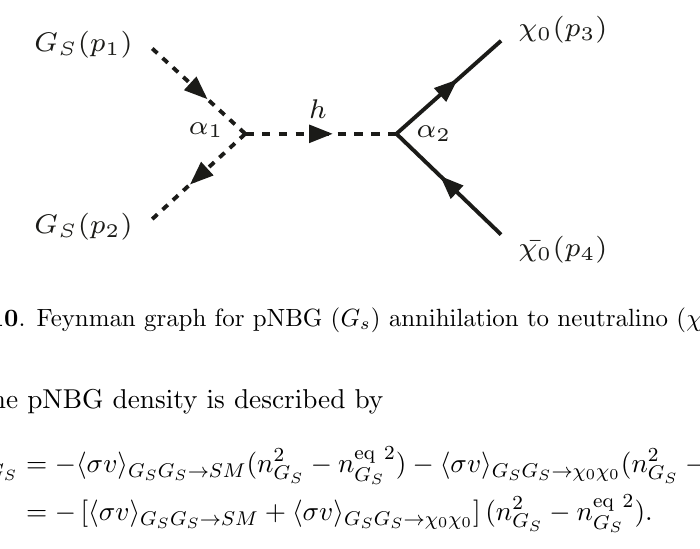
Table 1 . Relic density and corresponding SI direct detection cross section for wino/wino-Higgsino dominated neutralino with tan (cid:12) = 5. The input parameters in terms Bino ( M 1 ), Wino ( M 2 ) and Higgsino ( (cid:22) ) masses and the output in terms of neutralino mass and mixing parameters are indicated. All the masses are in GeVs. Spin independent direct search cross section is in cm 2 .